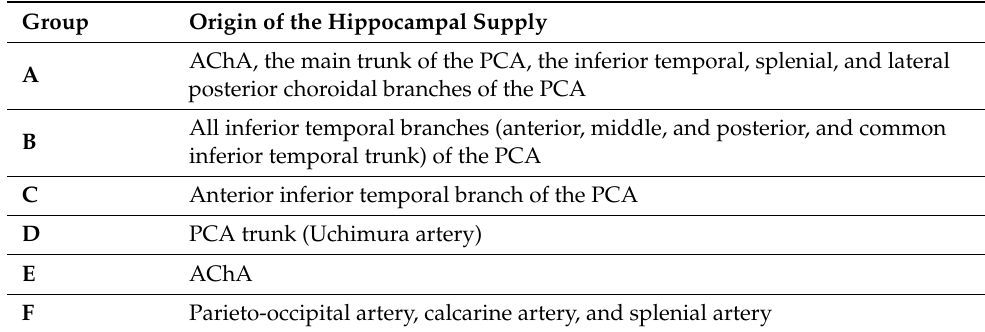
Table 1. Hippocampal vascularization according to Erdem et al. 1993 and Isolan et al. 2020 [20,24]. Group Origin of the Hippocampal Supply AChA, the main trunk of the PCA, the inferior temporal, splenial, and lateral posterior choroidal branches of the